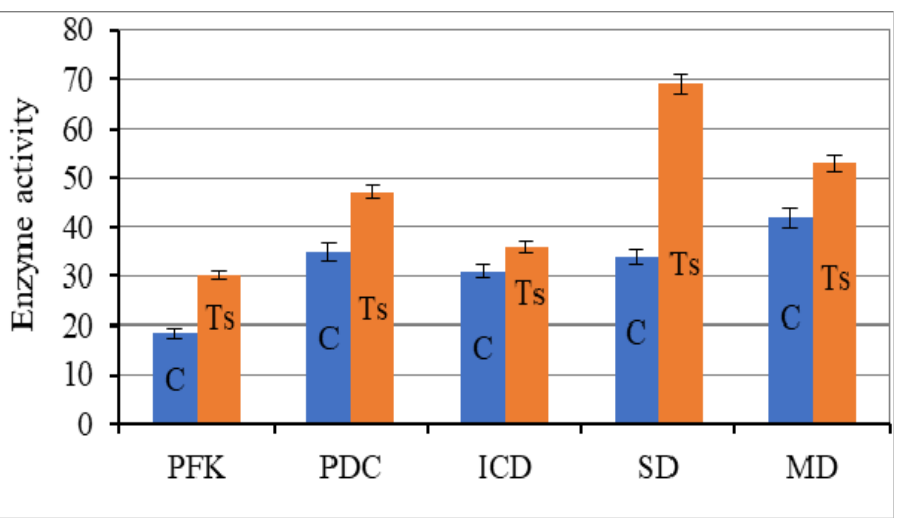
Figure 4. Effect of yeast treatment with ultrasound and a mix of Krebs cycle acids on the activity of enzymes: PFK: 6-phosphofructokinase ( µ mol fructose-6-phosphate/g DM · min · 10 − 2 ); PDC: pyruvate dehydrogenase complex; ICD: isocitrate dehydrogenase; SD: succinate dehydrogenase; MD: malate dehydrogenase (PDC, ICD, SD, MD– µ mol NADH/g DM · min); C: control; Ts: test sample. The figure illustrates the values with a statistically significant difference ≤